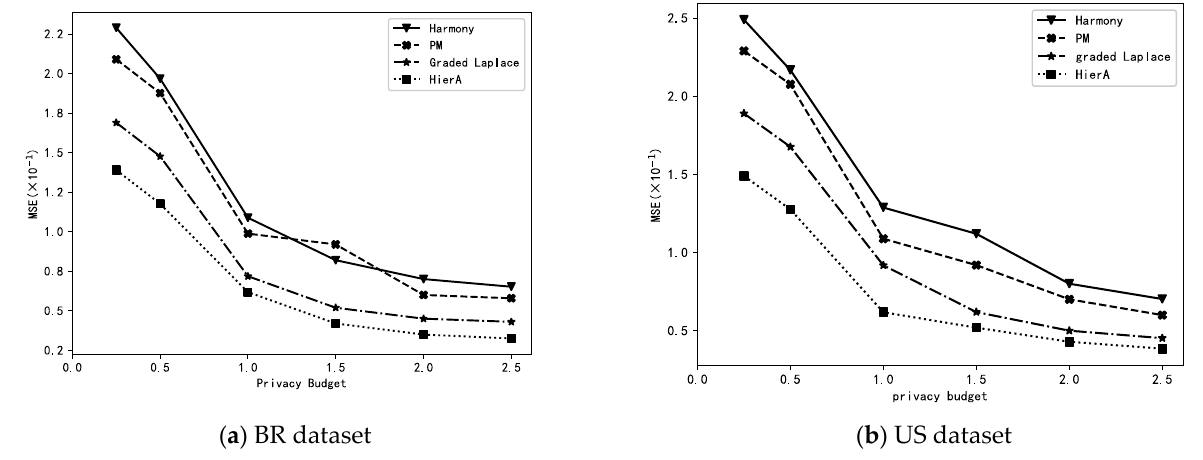
Figure 3. Linear regressions using different methods.